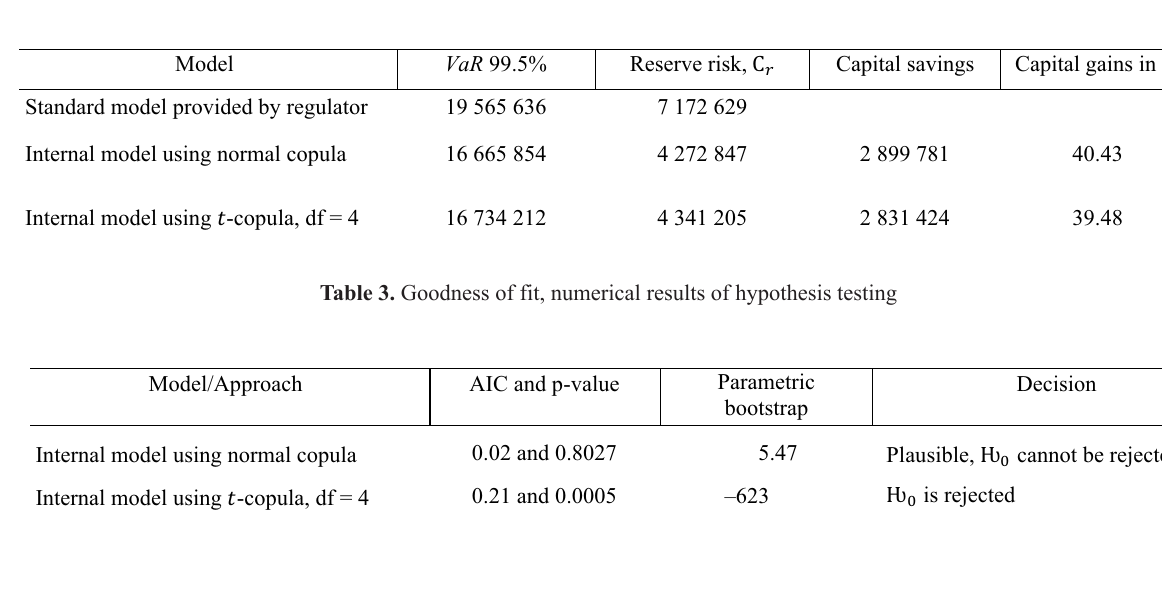
Table 2. Capital requirement results and capital gains in euros